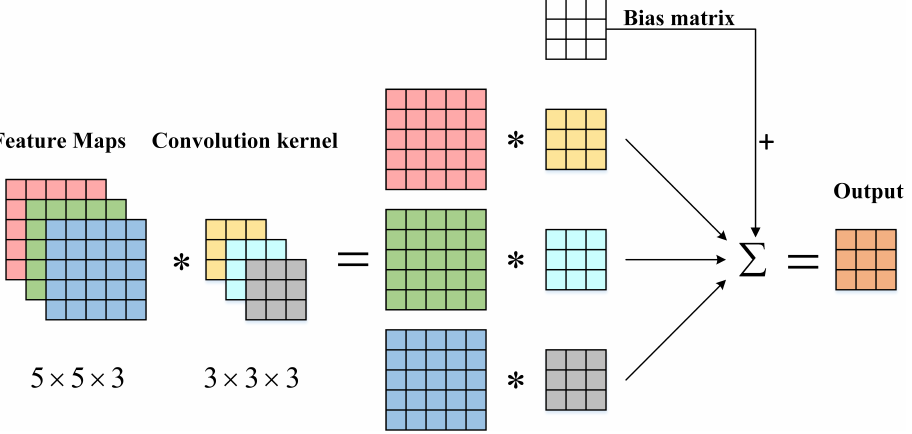
Figure 3. Schematic diagram of the convolution process.